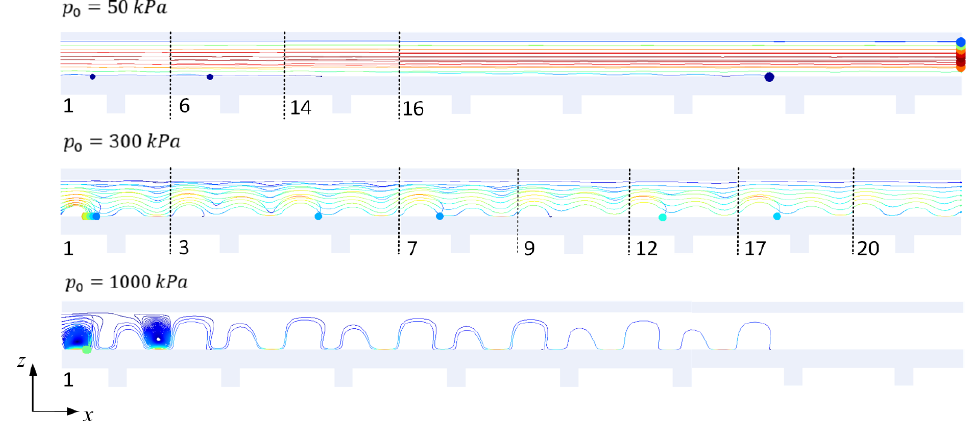
Figure 5. Motion trajectories of particles A and B in the channels under the conditions of u 0 = 5 mm/s, and p 0 = 50, 300 and 1000 kPa. The length of the channel was 20 times the lattice constant a of the PCP. For a more comprehensible figure, the areas without particles being trapped were omitted. The numbers at the bottom right of the dotted lines represent the actual period number of the lattice to the right of dotted lines.